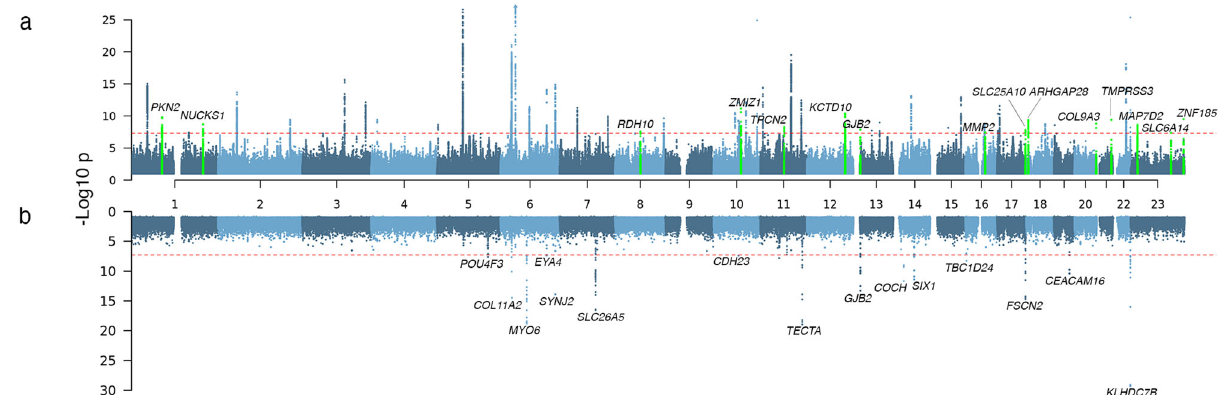
Fig. 1 Associations from the meta-analysis of hearing loss across 5 cohorts. a Common (MAF ≥ 0.01) variant associations with hearing loss. Colored in green are loci that have not previously been associated with hearing loss. b Rare (MAF < 0.01) coding single-variant and gene burden associations with hearing loss. The gene labels refer to the nearest